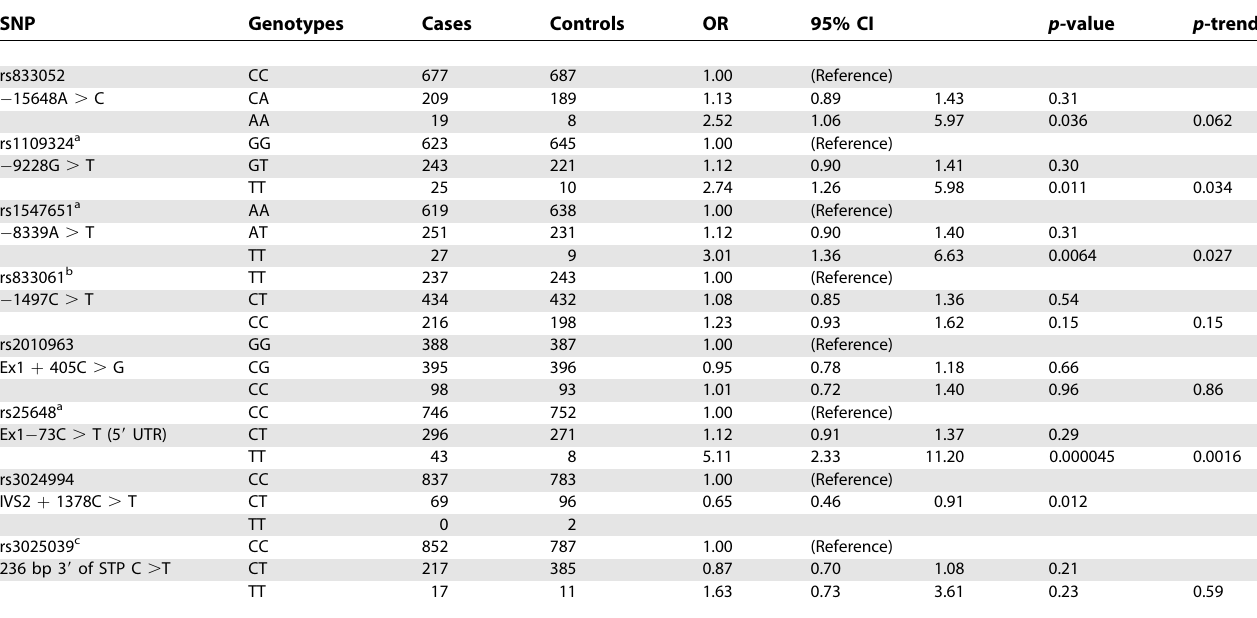
Table 2. Association between Selected VEGF Polymorphisms with Bladder Cancer Risk among 1,086 Cases and 1,033 Controls in the Spanish Bladder Cancer Study SNP Genotypes